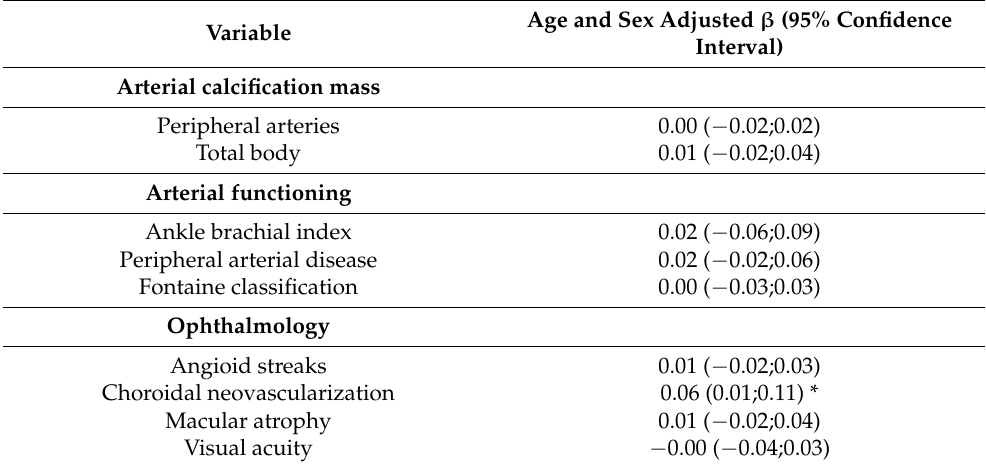
Table 2. Association between plasma PP i and different arterial and ophthalmological phenotypes.